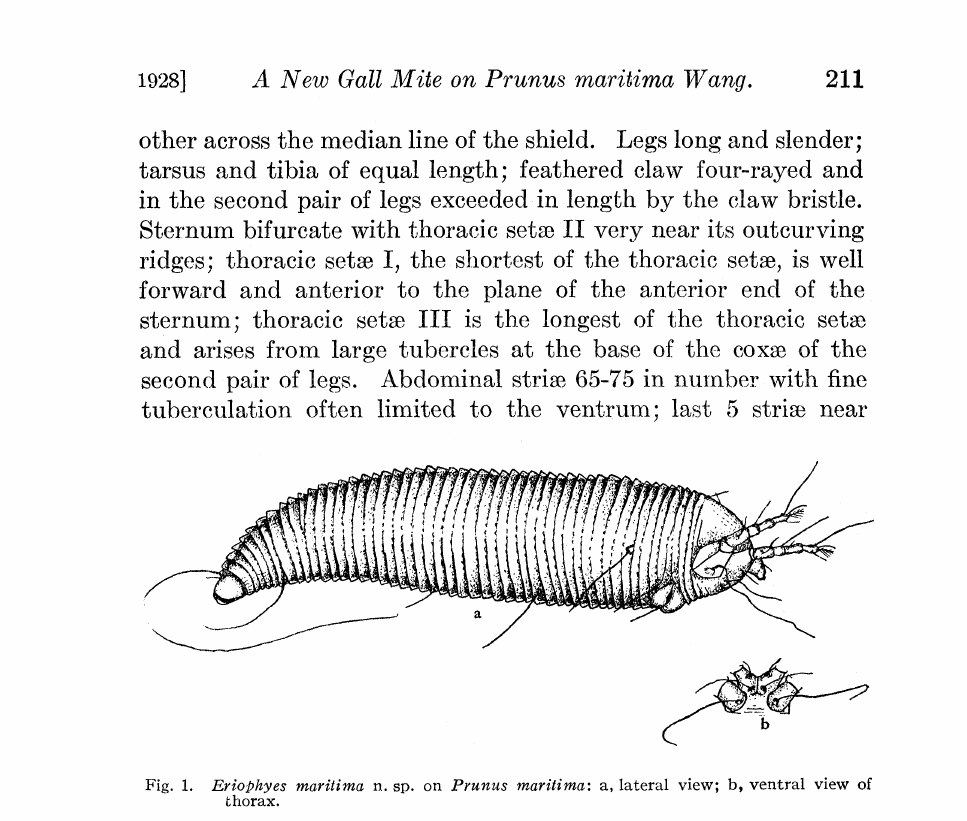
Fig. 1. Eriophyes maritima sp. on Prunus maritima: a, lateral view; b, ventral view of